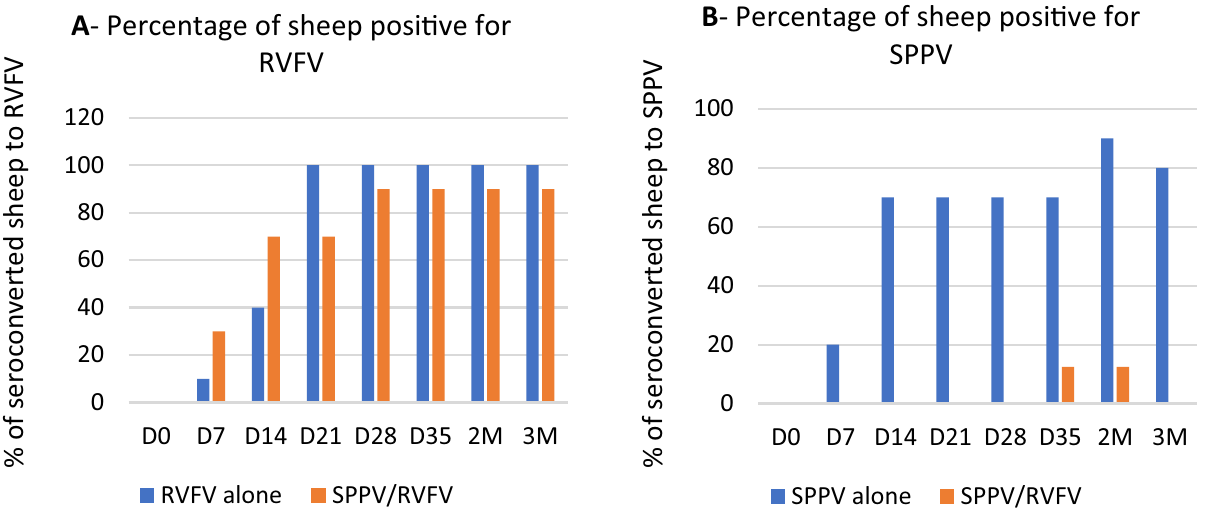
Figure 6. Percentage of antibody positive sheep (%) (n = 10) injected with RVFV alone, SPPV alone, or RVFV/ SPPV from D0 to 3 months pv. ( A ) RVFV antibody positive sheep, ( B ) SPPV antibody positive sheep in n = 10 each of tested groups. D: Days M: Months.